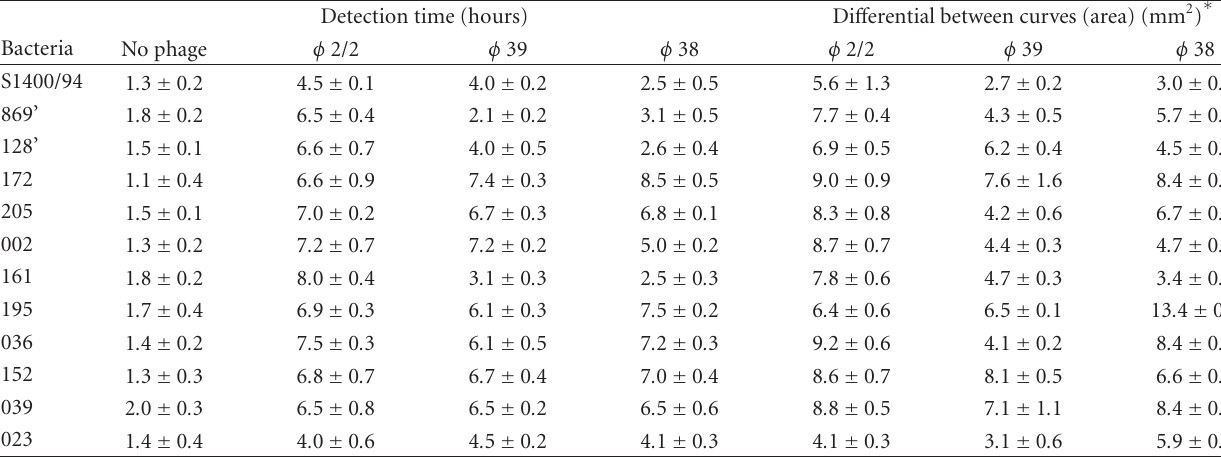
Table 4: Results obtained from conductimetric